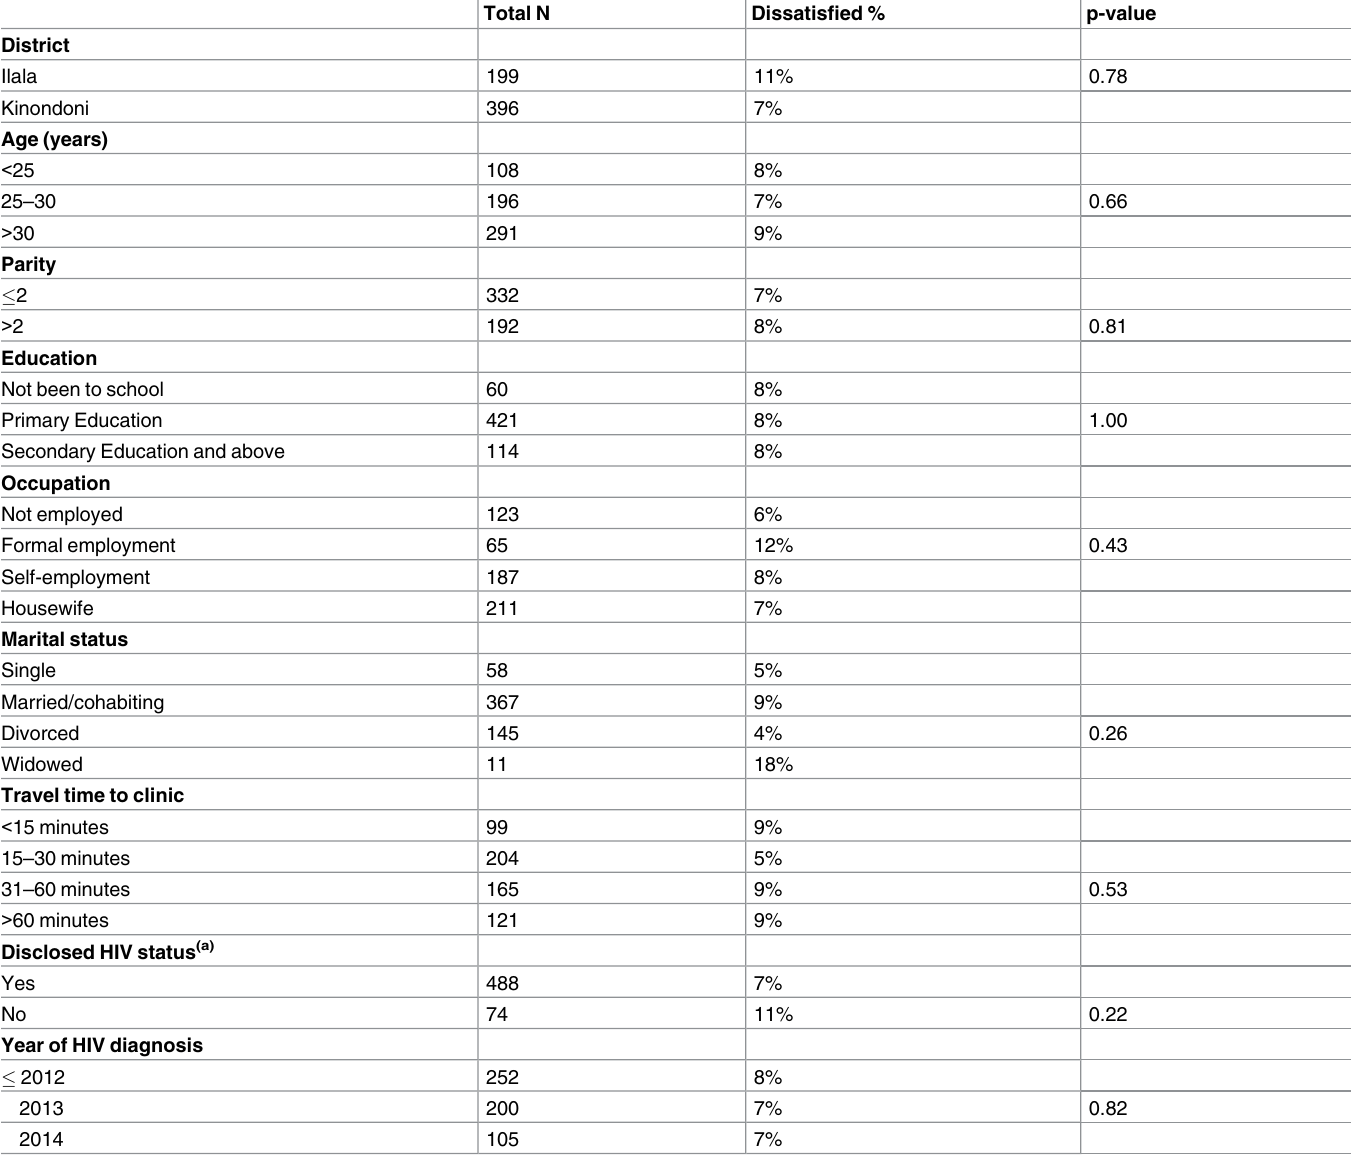
Table 1. Patient characteristics according to their dissatisfaction with PMTCT services(N =